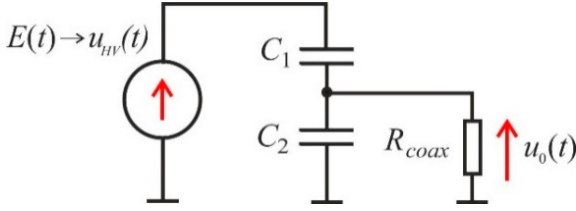
Figure 2. D-dot sensor equivalent diagram.